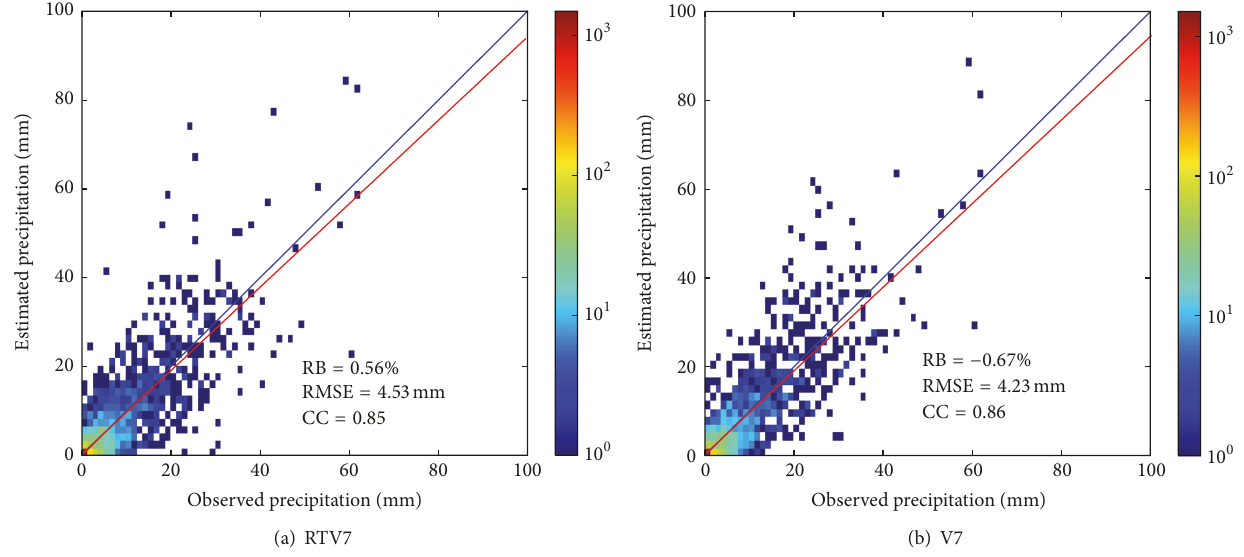
Figure 3: Scatter plots of TMPA versus observed precipitation in the Ganjiang River basin ((a) RTV7; (b)